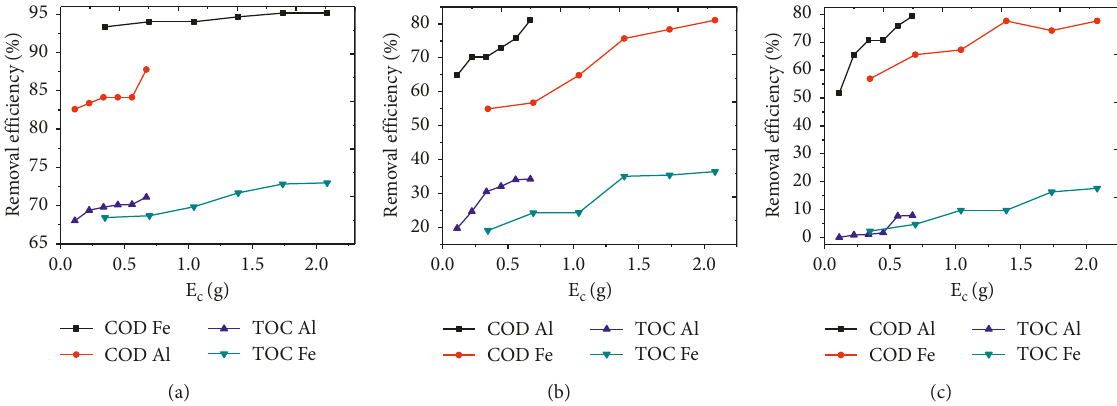
Figure 7: Removal of COD and TOC for an EC process with different amounts of iron or aluminium adsorbent. Conditions: pH 7.0; S2 (a), S3 (b), and S4 (c) wastewater; electrolysis time � 60